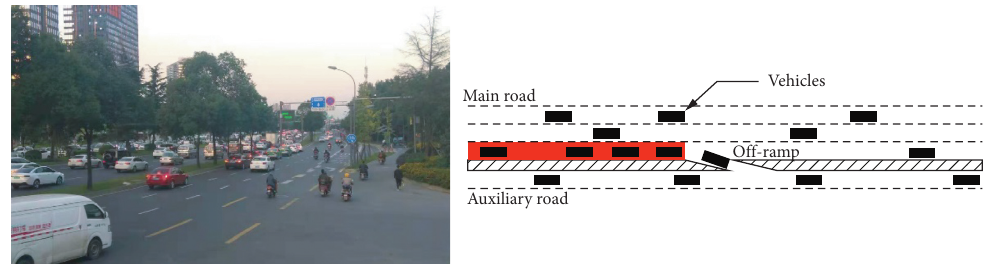
Figure 1: Queue of vehicles caused by traffic volume exceeding the queue storage space of